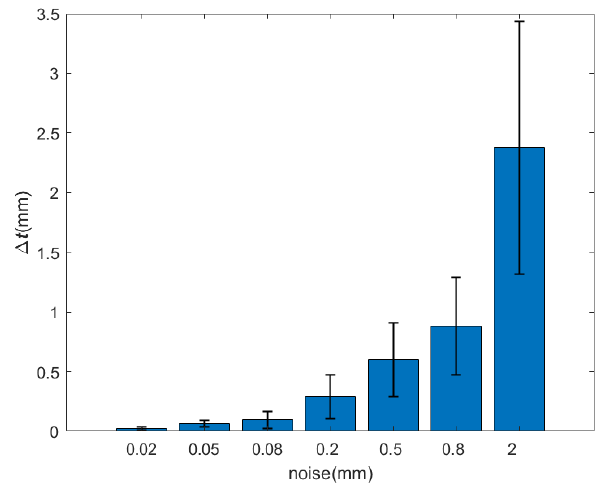
Figure 17. Standard model of circle